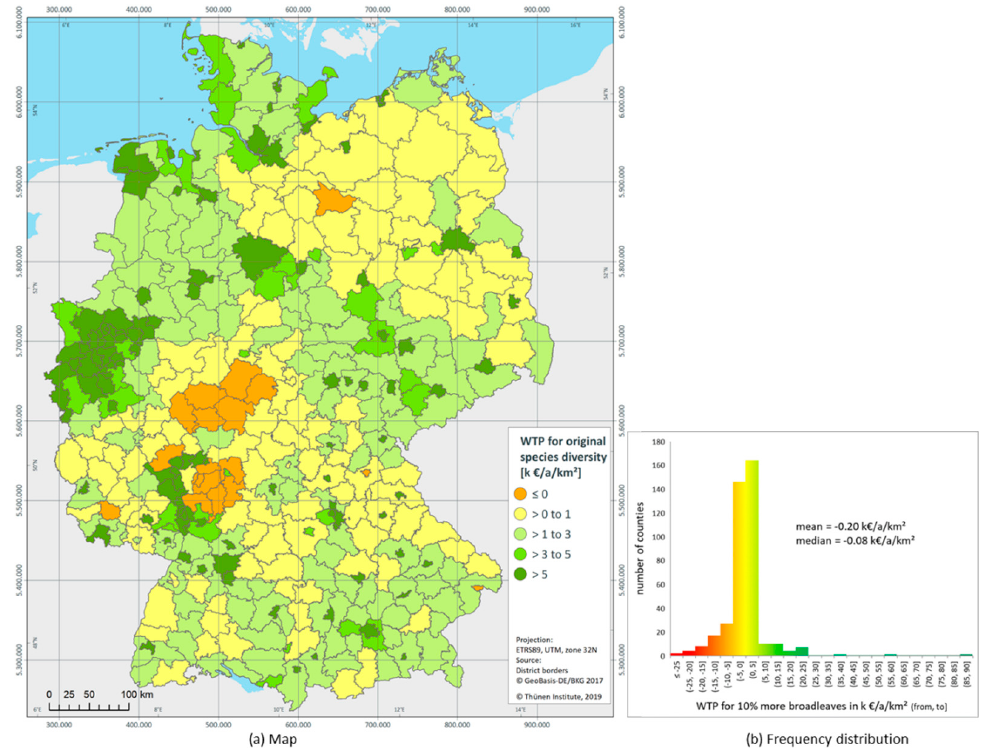
Figure 8. Annual benefits of restoring original species diversity in the counties.